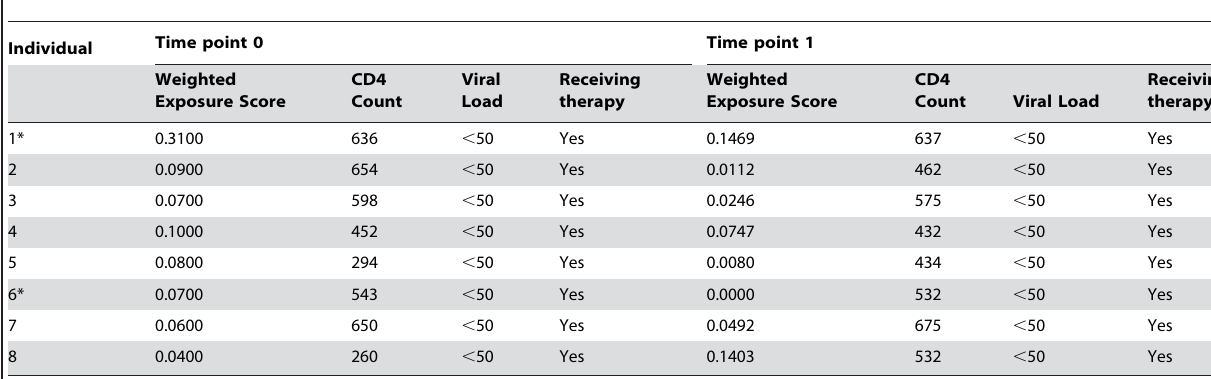
* indicates that the individuals partner started to receive anti-retroviral therapy after time point 0, and had a viral load below 50 copies per ml.